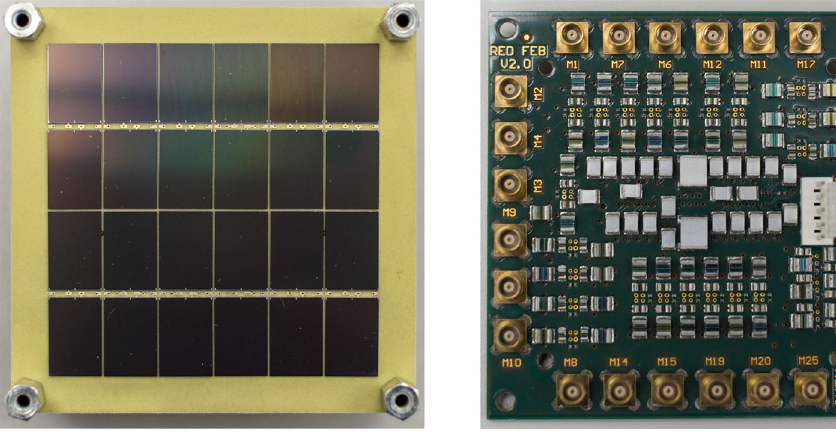
Fig. 4 Left: 24 rectangular NUV-HD-Cryo SiPMs from FBK, assembled onto a 5 cm × 5 cm tile. Right: the 24-channel Front-End Board (FEB) used for reading out the top tile